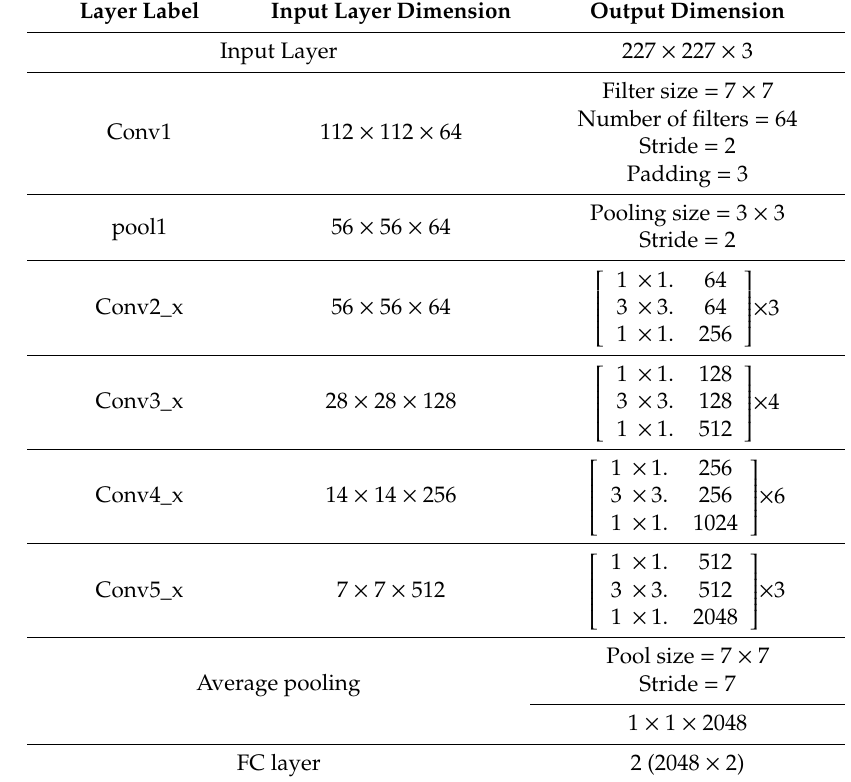
Figure 4. The architecture of the ResNet 50 DCNN. Table 3. Different layers dimensions of the ResNet 50 DCNN.